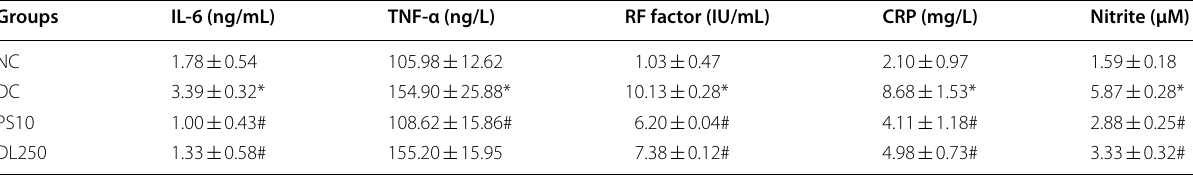
Table 4 Effect of C. procera on biochemical parameters of CFA-induced arthritic rats Groups